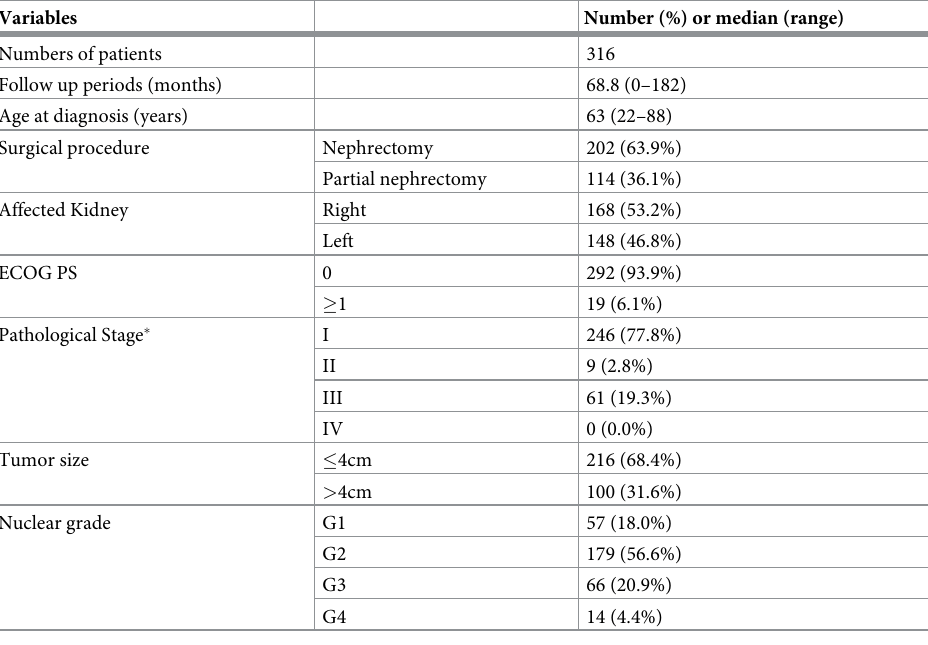
Table 1. Patient and tumor characteristics at primary radical